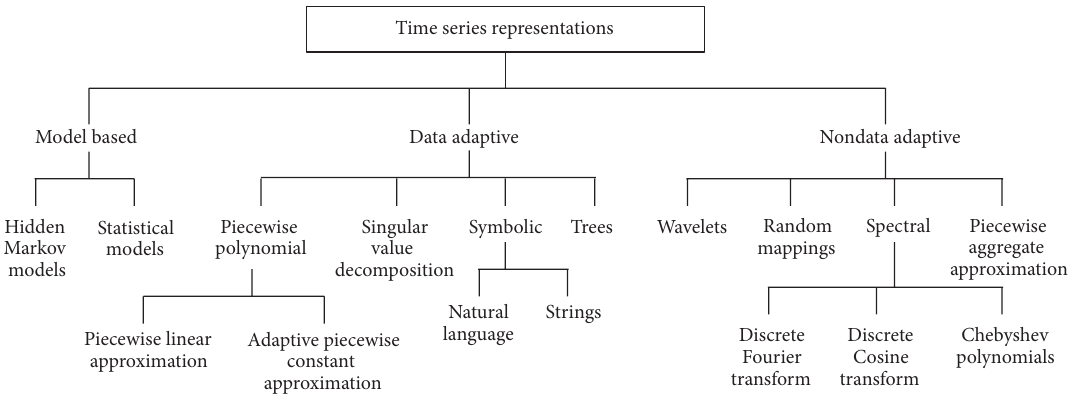
Figure 2: Time series representations